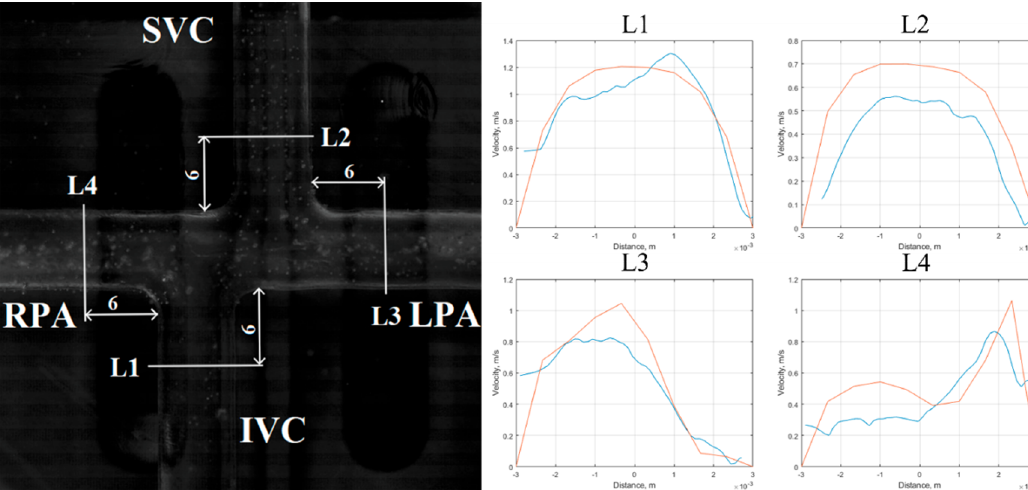
Figure 11. Velocity modulus distribution in various sections for TCPC ‐ 2: red line—CFD modeling, blue line—experimental data. L3 and L4 repeat the distribution shape. At L1 (blue line) it is shifted towards the LPA. L2 (blue line) reflects the presence of an additional local hydraulic resistance.